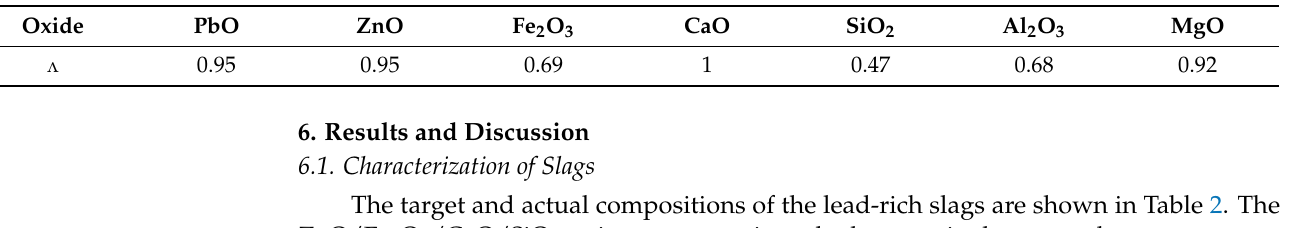
Table 1. The optical basicity of individual oxide [13,15].